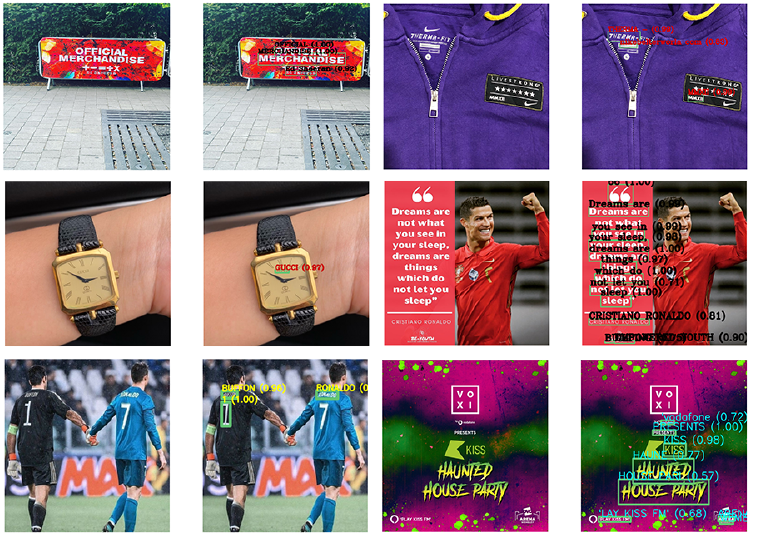
Figure 2. Sample images and recognition of corresponding overlaying text in different